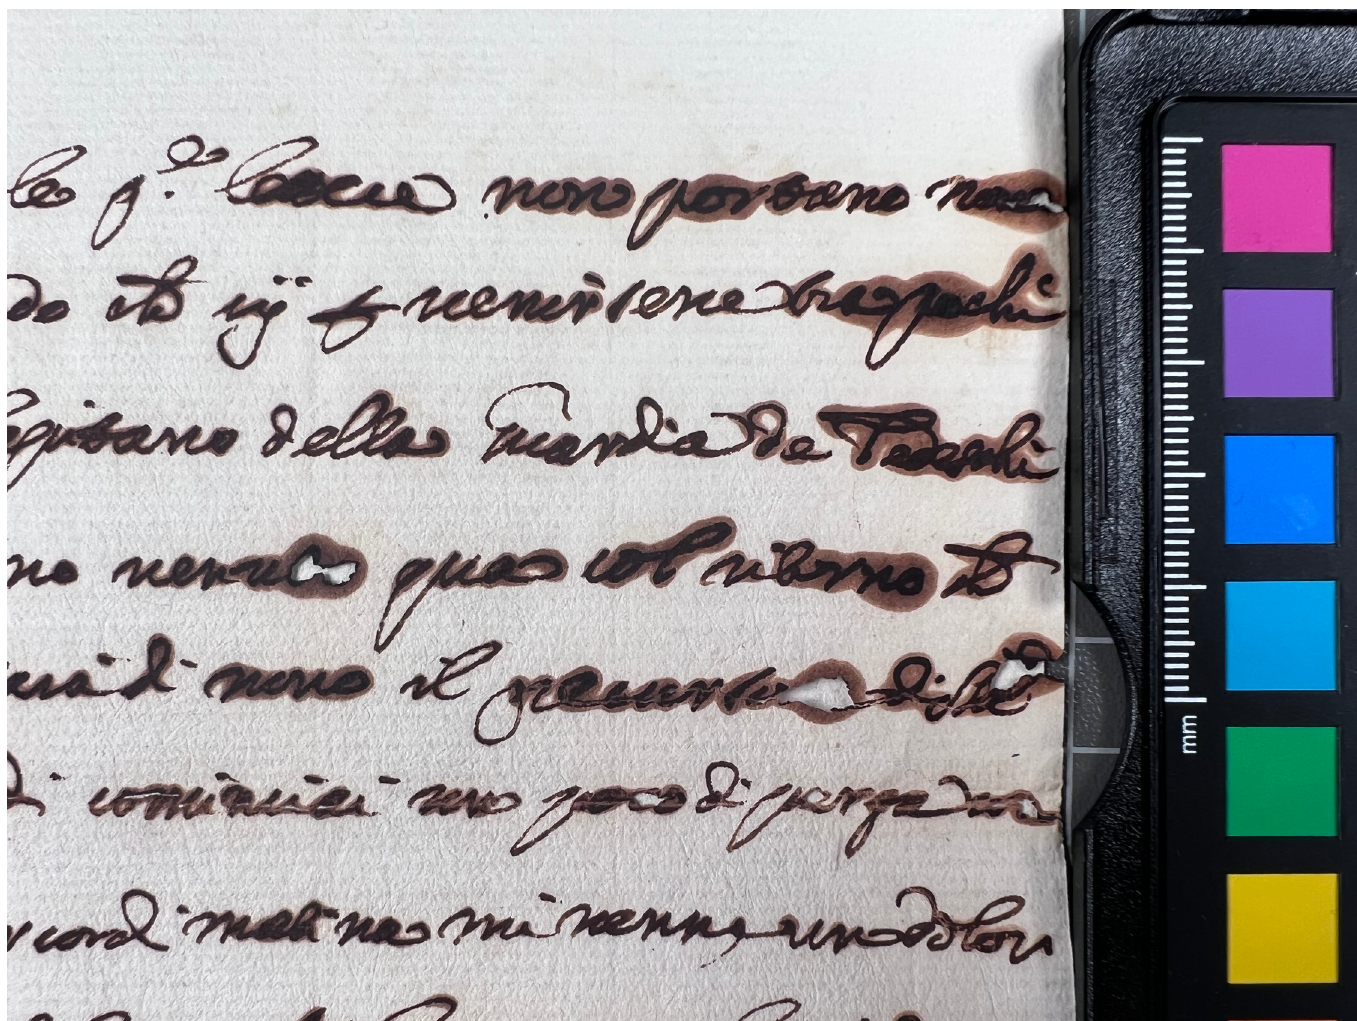
Fig 5. Ink halos. Ink halos due to ink corrosion. This particular document from volume K 400 of the Azzolino collection.